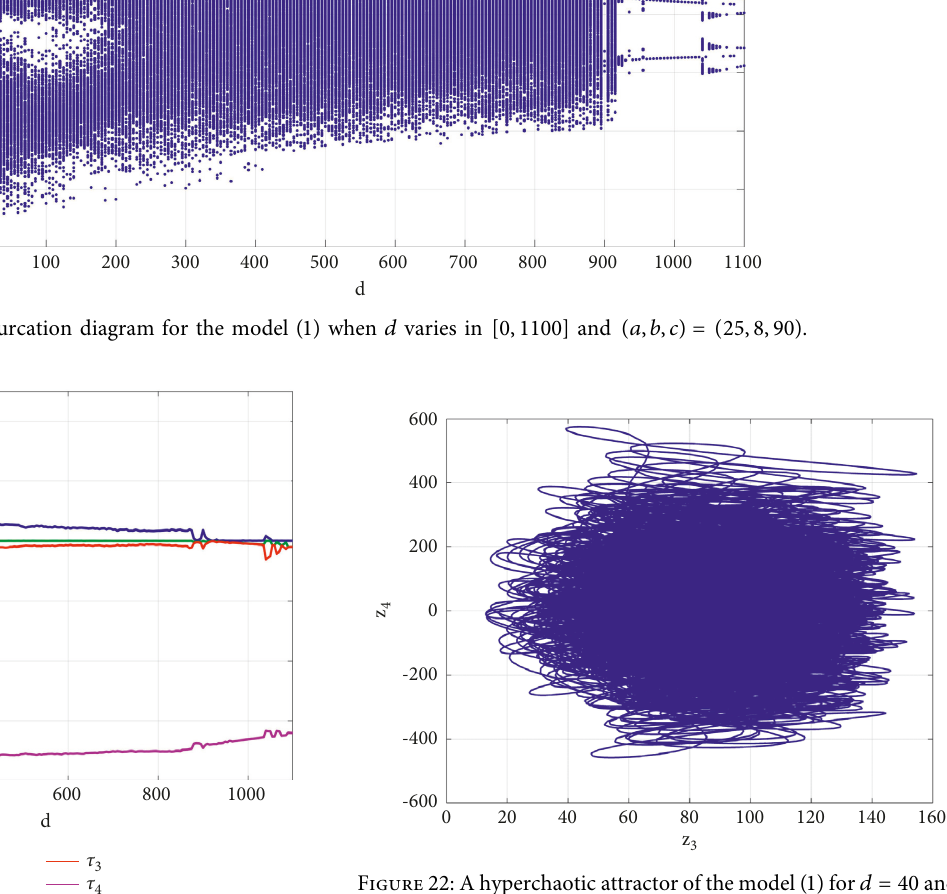
Figure 21: Lyapunov exponents for the model (1) when d varies in [ 0 , 1100 ] and ( a,b, c ) � ( 25 , 8 , 90 ) .